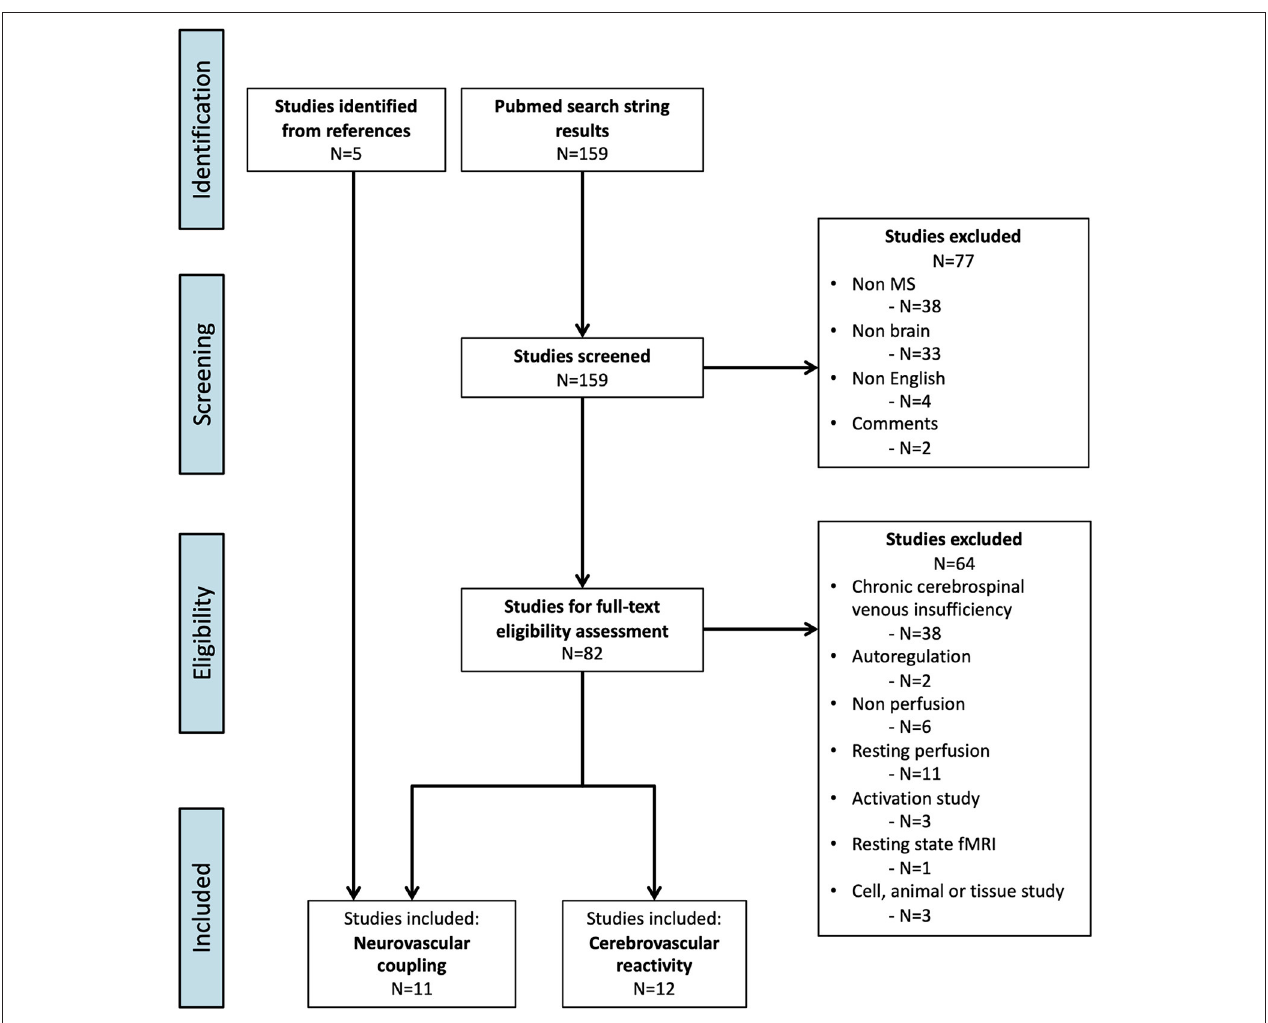
FIGURE 1 | Flowchart of the inclusion process (PRISMA flow diagram)